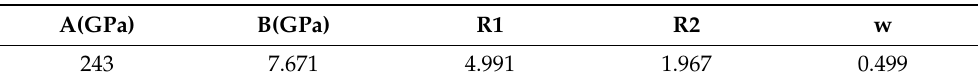
Table 4. Jones–Wilkins–Lee (JWL) and Chapman–Jouguet (C-J) characteristic values (emulsion